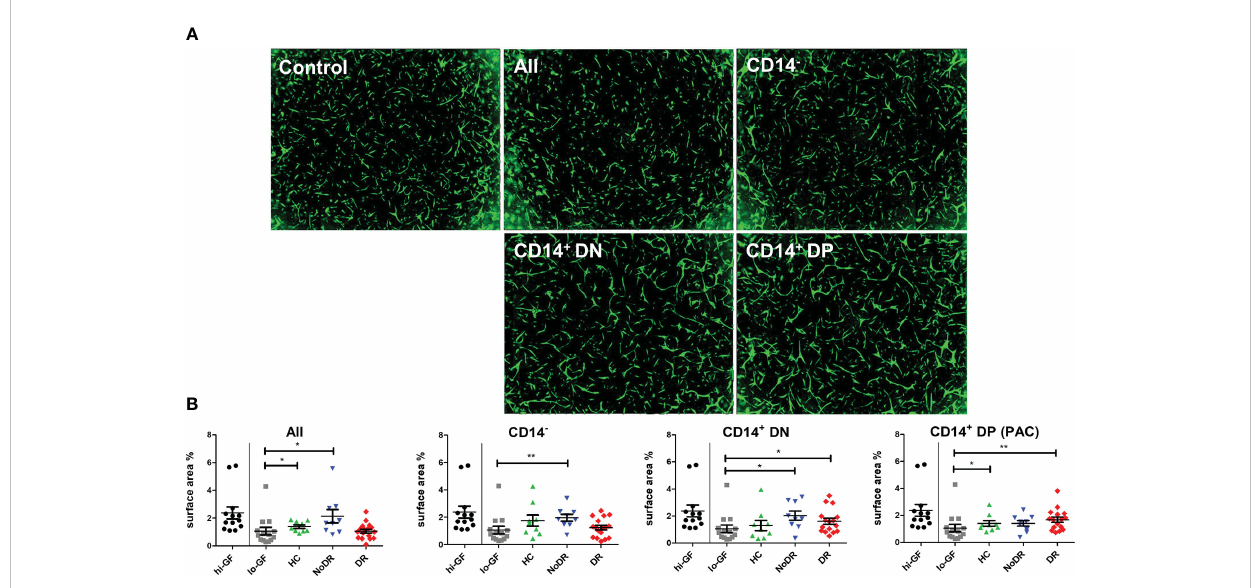
FIGURE 2 PAC culture-derived cells from patients with T2DM with and without DR enhance in vitro angiogenesis. PBMC isolated from HC (n = 9), NoDR (n = 9), and DR patients (n = 17) were cultured to differentiate into PAC. The total cell culture population (All), or fl ow-sorted subsets (CD14 – CD105 – CD133 – (CD14 – ), CD14 + CD105 – CD133 – (CD14 + DN), or CD14 + CD105 + CD133 + (CD14 + DP, PAC)) (500 cells) were introduced into a gelatin-based 3- D in vitro tubule formation assay of retinal endothelial cells (REC) and pericytes supplemented with low concentrations of pro-angiogenic growth factors (lo-GF). After 4 days, REC tubule formation was visualized by fl uorescence microscopy. (A) Representative images from co-cultures stimulated with different sorted cell subsets from a DR patient. ‘ Control ’ indicates the angiogenesis observed in a lo-GF culture. (B) Quanti fi cation of angiogenesis represented as total REC surface area percentage. Each experiment included culture quality controls with high growth factor concentration (hi-GF) and lo-GF, and tested different cell subsets from HC and patients in lo-GF condition. Dots show data from individual cultures (average of at least 4 technical replicates) in separate experiments normalized to the average of lo-GF control. Error bars represent means ± standard error of the mean (SEM). Signi fi cance was calculated compared to the lo-GF control using Mann Whitney U T-test. *p < 0.05, **p <